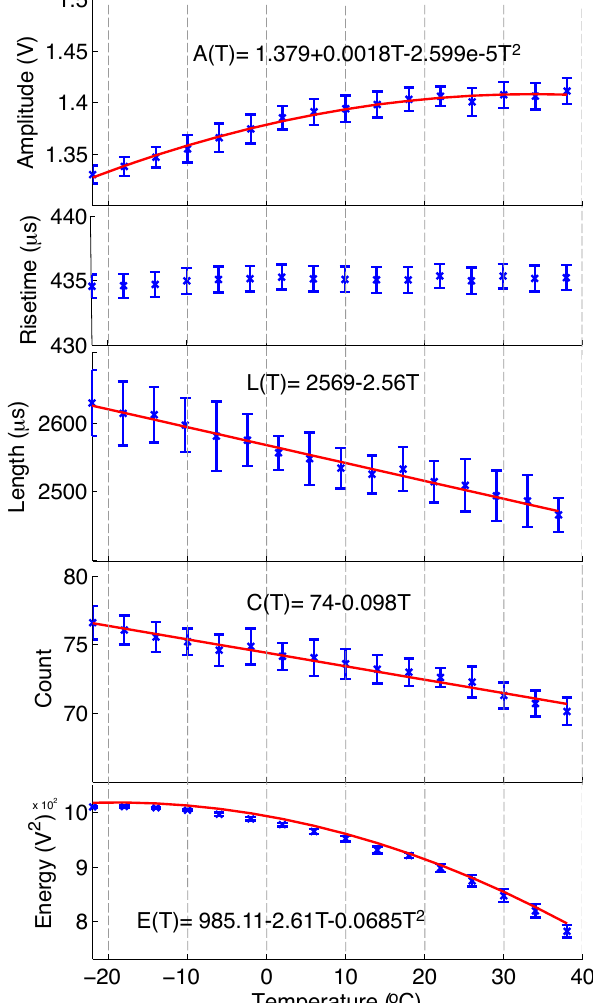
Fig. 4. Temperature dependency of measured AE signal parameters (mean and standard deviation) over a range from − 20 to 40 ◦ C. The rise time parameter remains stable, whereas all other parameters show a noticeable temperature dependence. Linear regressions with respect to temperature ( T ) are given for the length ( L ) and count ( C ), while quadratic regressions are given for the amplitude ( A ) and energy ( E